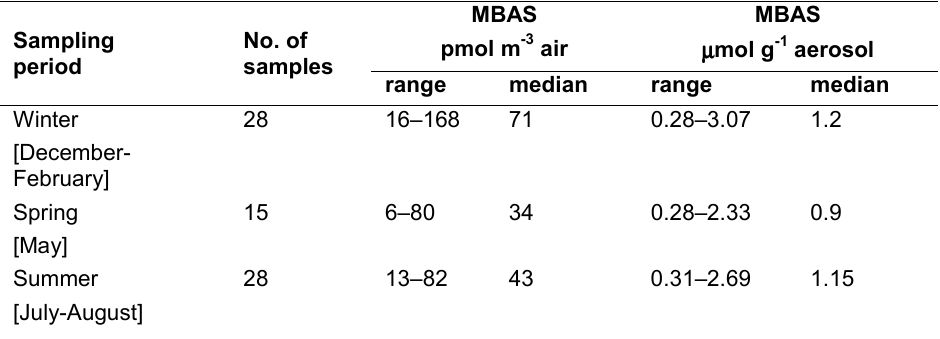
Range of Methylene Blue Active Substances (MBAS) in Aerosol Samples Collected during Three Seasons